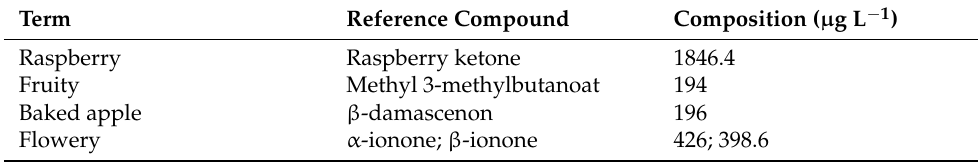
Table 1. Reference aroma substances and their concentrations used in descriptive aroma